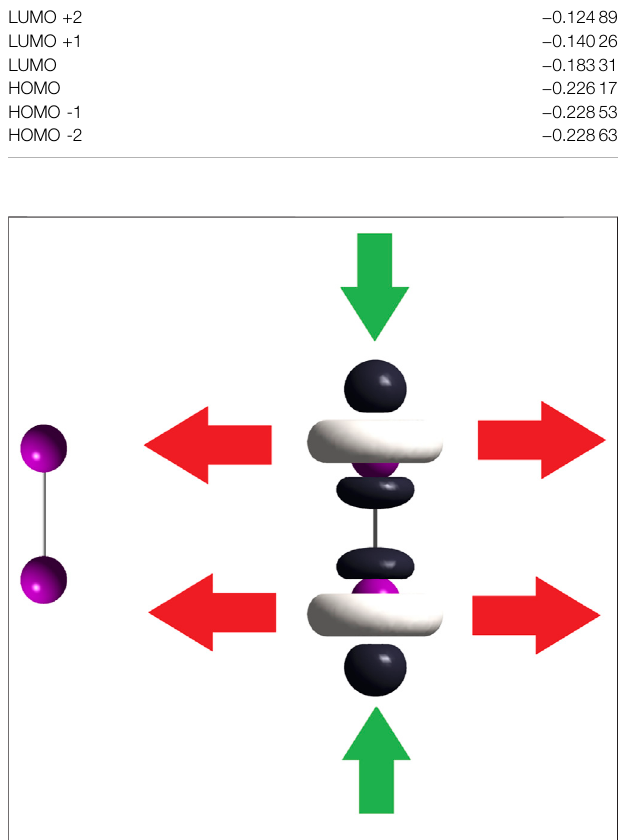
FIGURE 5 | On the left side, the iodine molecule; on the right side, dual descriptor of this molecule. Green arrows indicate the electron – acceptor (electrophilic) regions leading to a linear “ end – on ” coordination mode and red arrowsshowustheelectron – donor(nucleophilic)regionsthusleadingto a bent “ end – on ” coordination